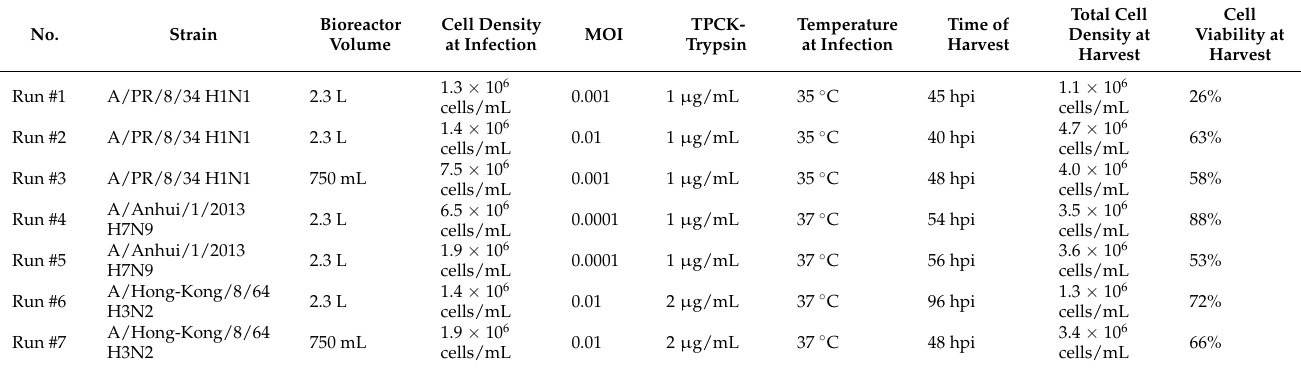
Table 1. Upstream operational conditions and